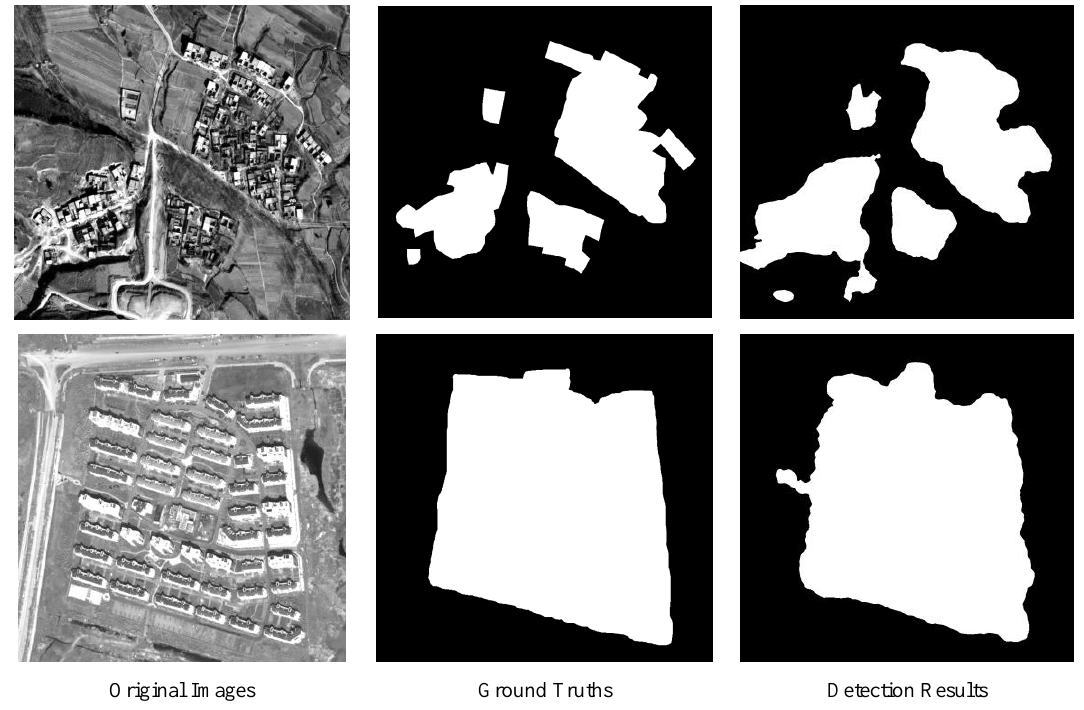
Figure 3. Built-up area detection results for part of the Quickbird